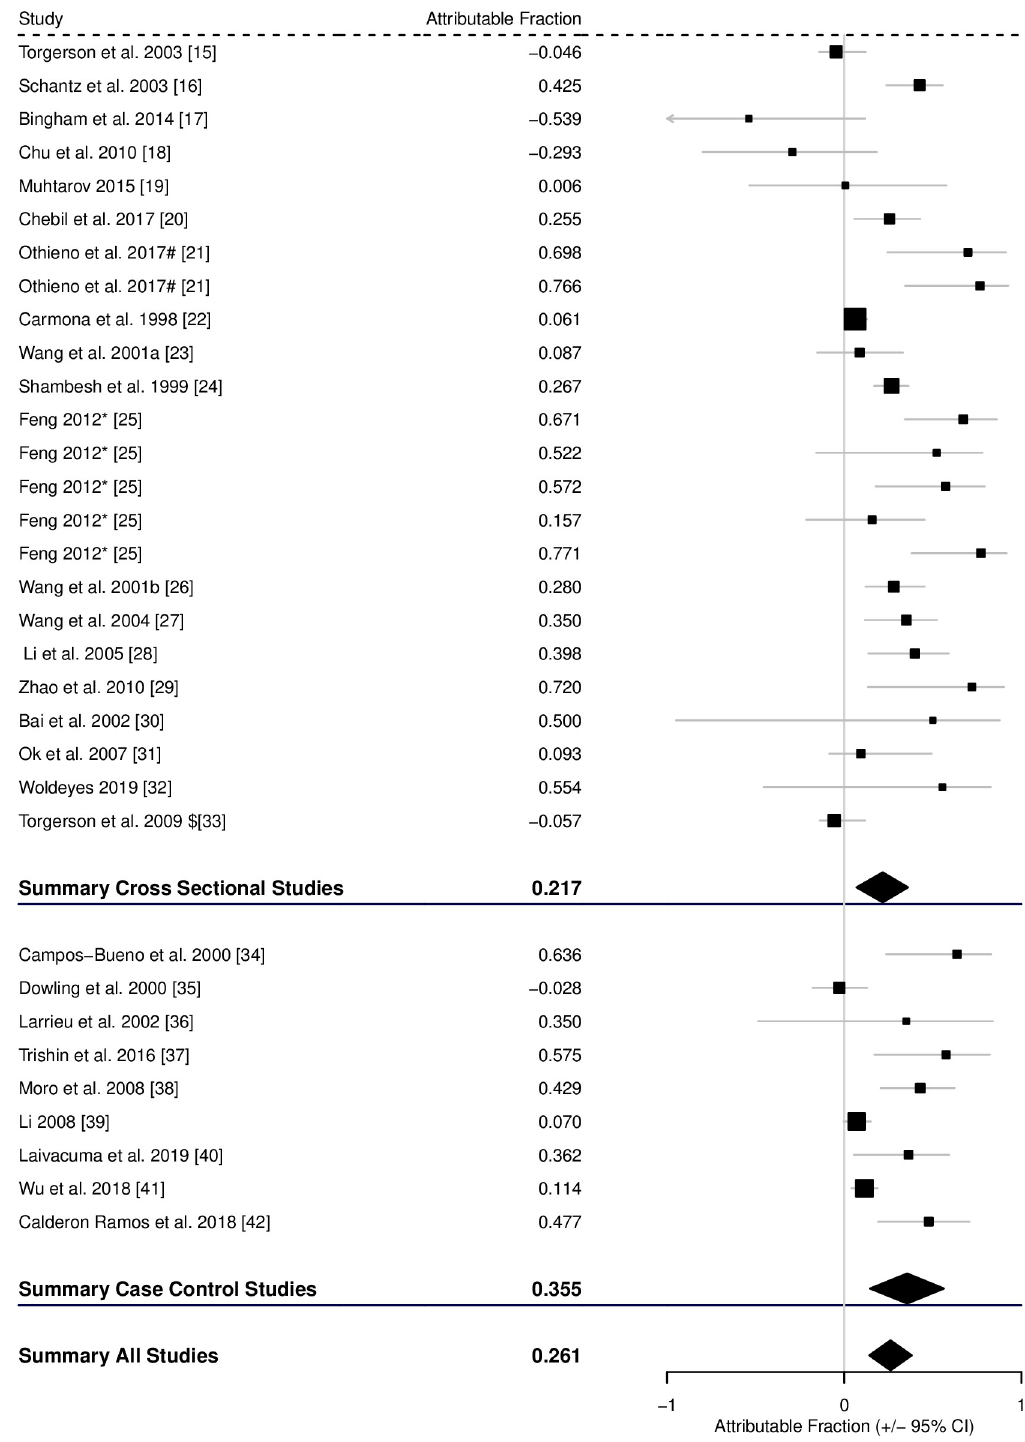
Fig 3. Forest plot for the attributable fraction for 24 cross-sectional studies and 9 case-control studies that analysed potential contact with infected dogs as a potential risk factor for CE. � and # indicate different studies from the same published report. $ Data not reported in study, but supplied by the authors.